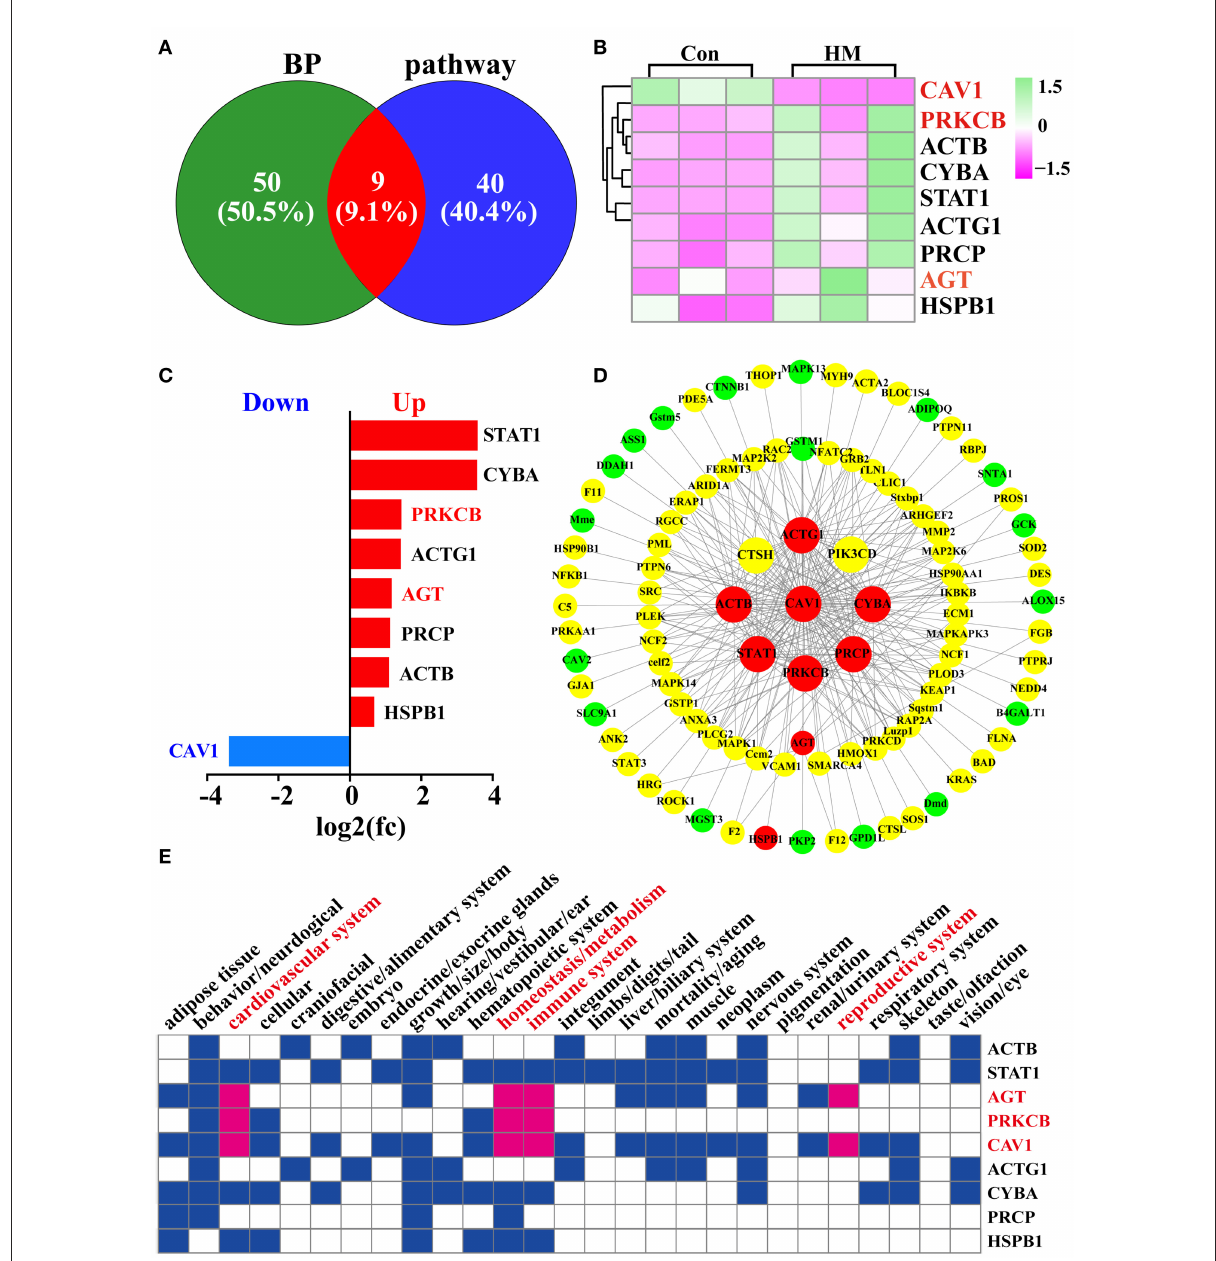
FIGURE6 Identification and functional analysis of DEPs related to blood, vascular or vasculature, and angiogenesis selected from the GO terms and KEGG pathways. (A) Venn diagram of the DEPs related to blood, and vasculature or vascular selected from the GO terms and KEGG pathways. (B) Heat-map of the nine shared DEPs selected from the GO terms and KEGG pathways. (C) the relative expression levels of the nine shared DEPs quantified by DIA proteomics using log 2 (FC) values. (D) PPI network of the 99 DEPs after overlapping GO terms and KEGG pathways. (E) phenotype prediction and functional analysis of the nine representative DEPs. Con, Control group; HM, Hemorrhagic